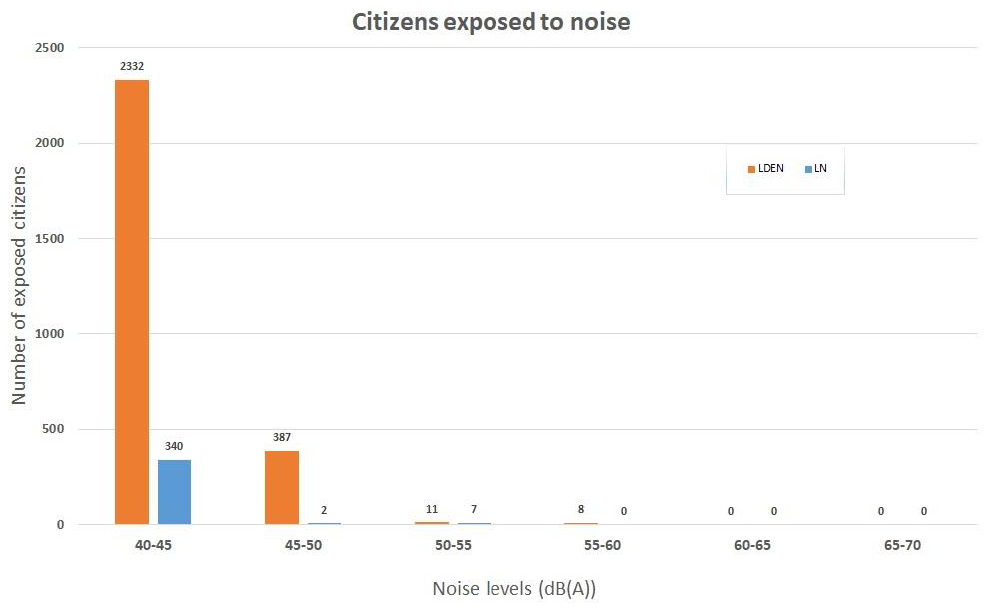
Figure 10. Number of citizens exposed to noise levels above 40 dB(A) L DEN or L N in Scenario 4.